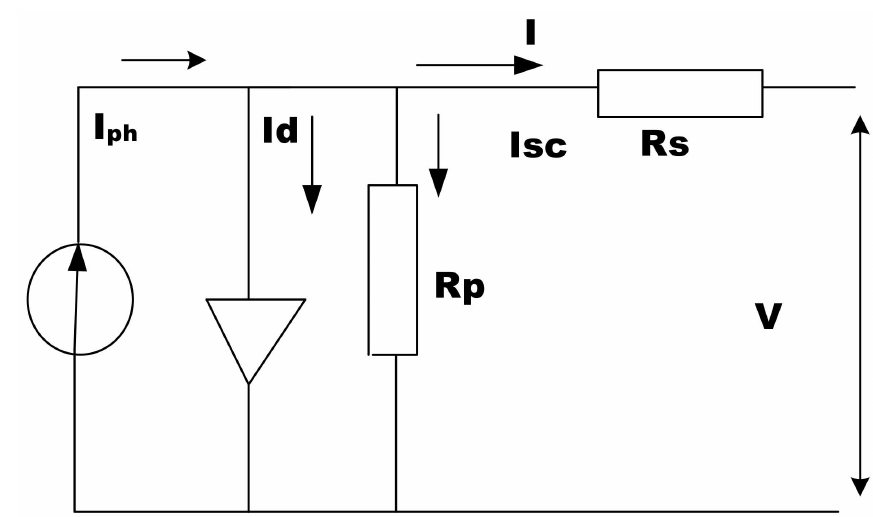
Figure 1. Equivalent circuit of PV panel